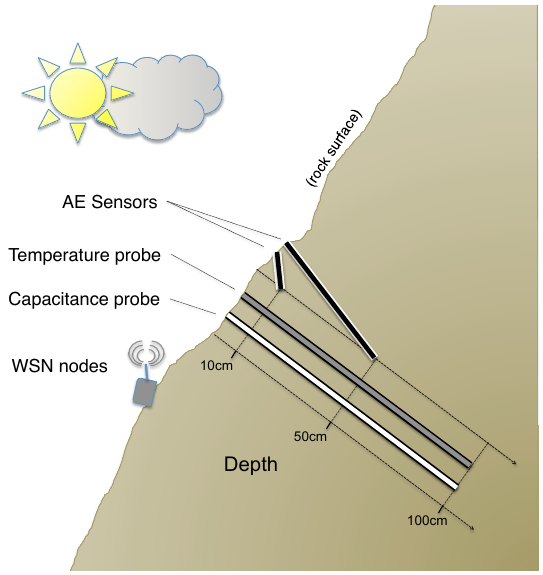
Fig. 9. Schematic view of the field setup of the measurement